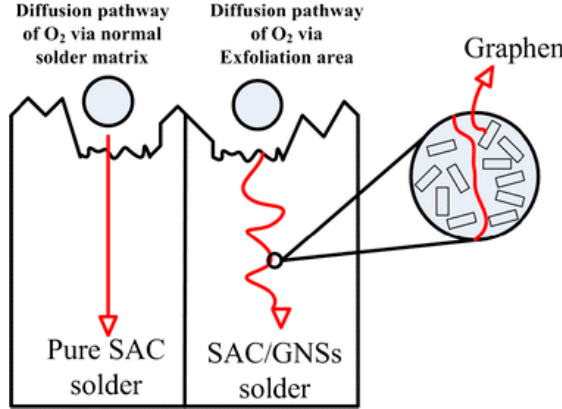
Figure 7. Schematic representation of the inhibition effect of graphene nanosheets (GNSs) on oxygen diffusion [54].